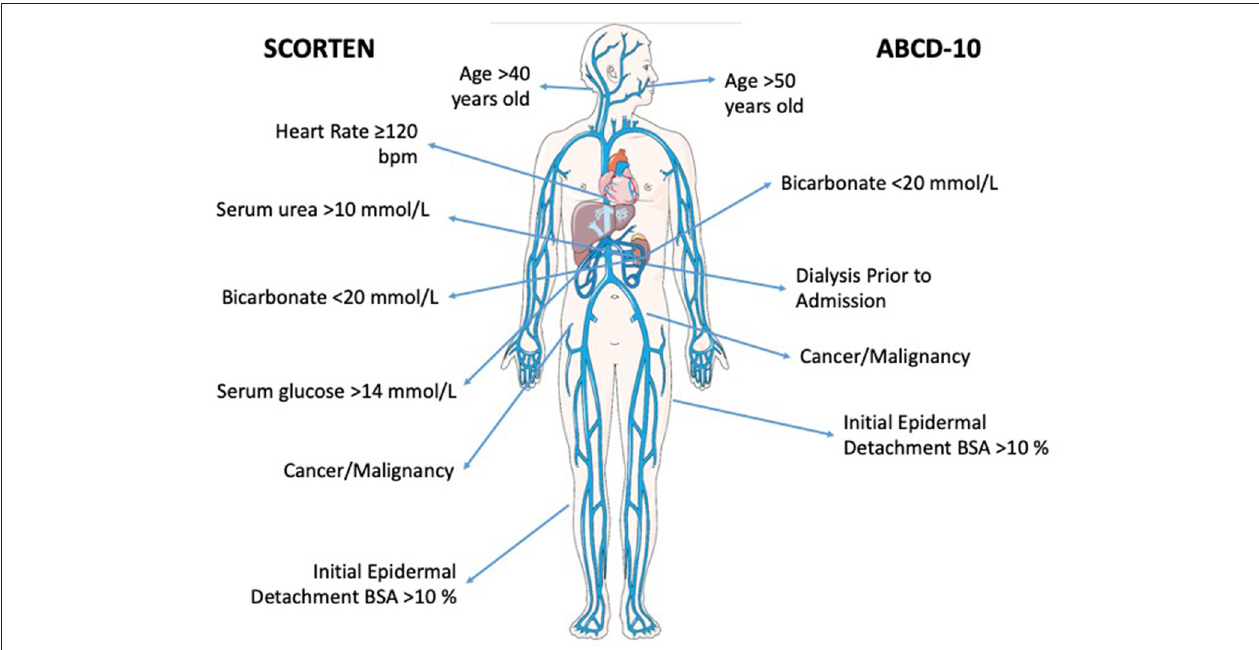
FIGURE 1 | Bioicon representation of the prognostic factors associated with both SCORTEN and ABCD-10 scoring systems. Venous-circulation-body icon by Servier https://smart.servier.com/ is licensed under CC-BY 3.0 Unported https://creativecommons.org/licenses/by/3.0/